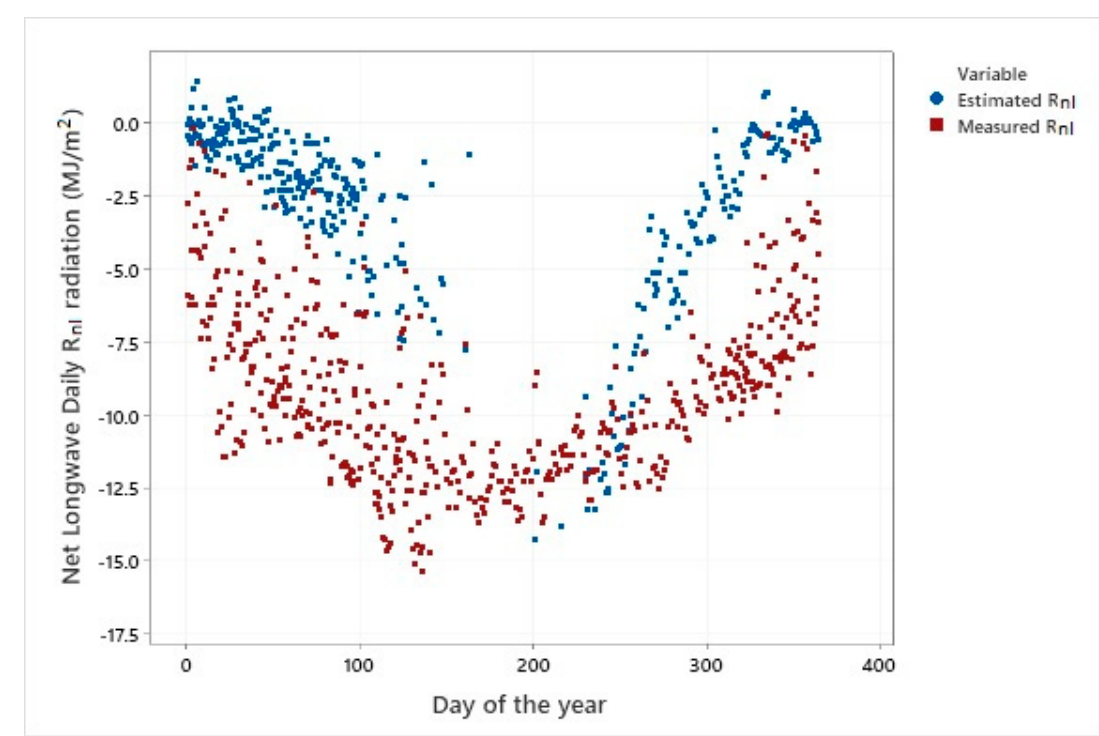
Figure 20. Comparison of the estimated Equation (21) and the measured daily net longwave radiation, at Athalassa.